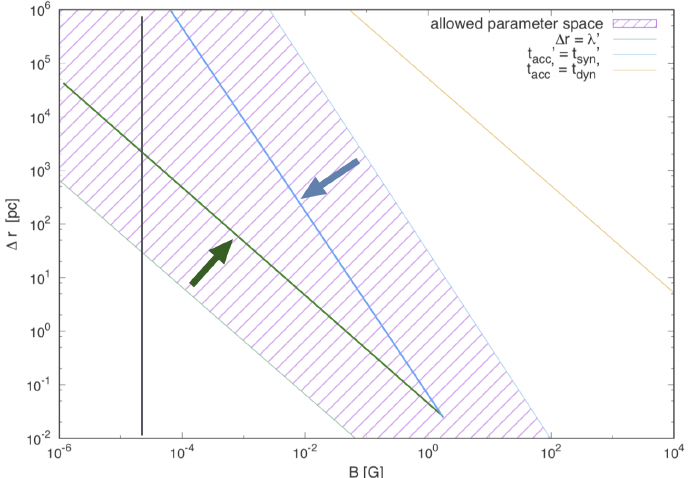
Figure 17. Allowed (shaded) parameter range, i.e., magnetic field strength B , shear layer width ∆ r , to facilitate gradual shear acceleration of protons in (mildly relativistic) large-scale AGN jets, and to comply with confinement and synchrotron loss constraints. A Kolmogorov-type scaling for the particle mean free path ( λ ∝ γ 1/3 ) has been assumed. While for protons, EeV energies are well achievable, shear acceleration of protons to ∼ 100 EeV in mildly relativistic jet flows appears quite restricted (to the parameter space confined by the arrows). Following ref.